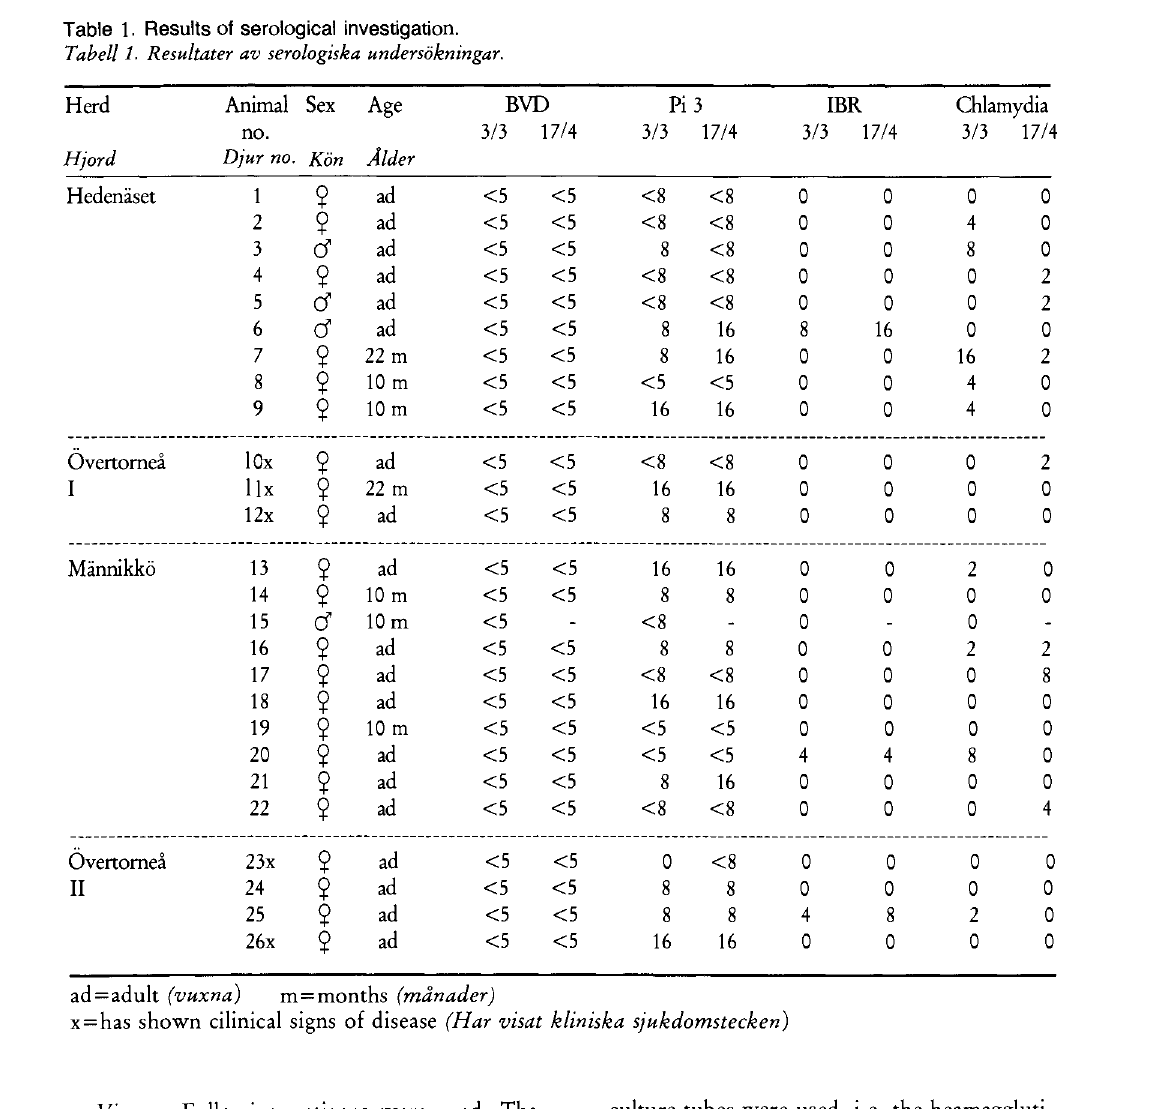
Table 1 . Results of serological investigation. Tabell 1. Resultater av serologiska